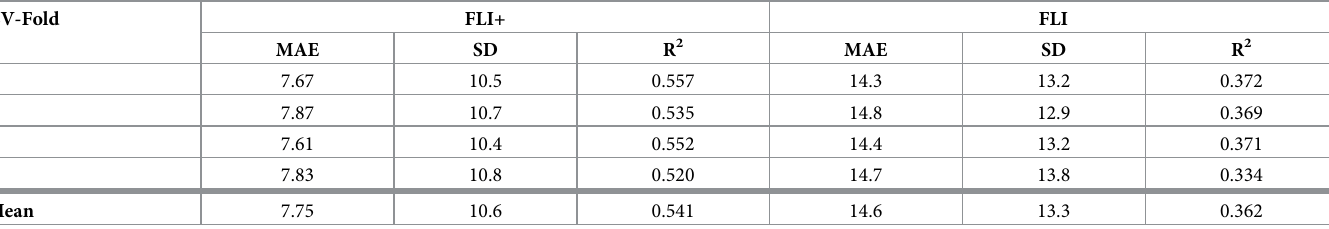
Table 3. Performance of FLI+ versus FLI. CV-Fold FLI+ MAE